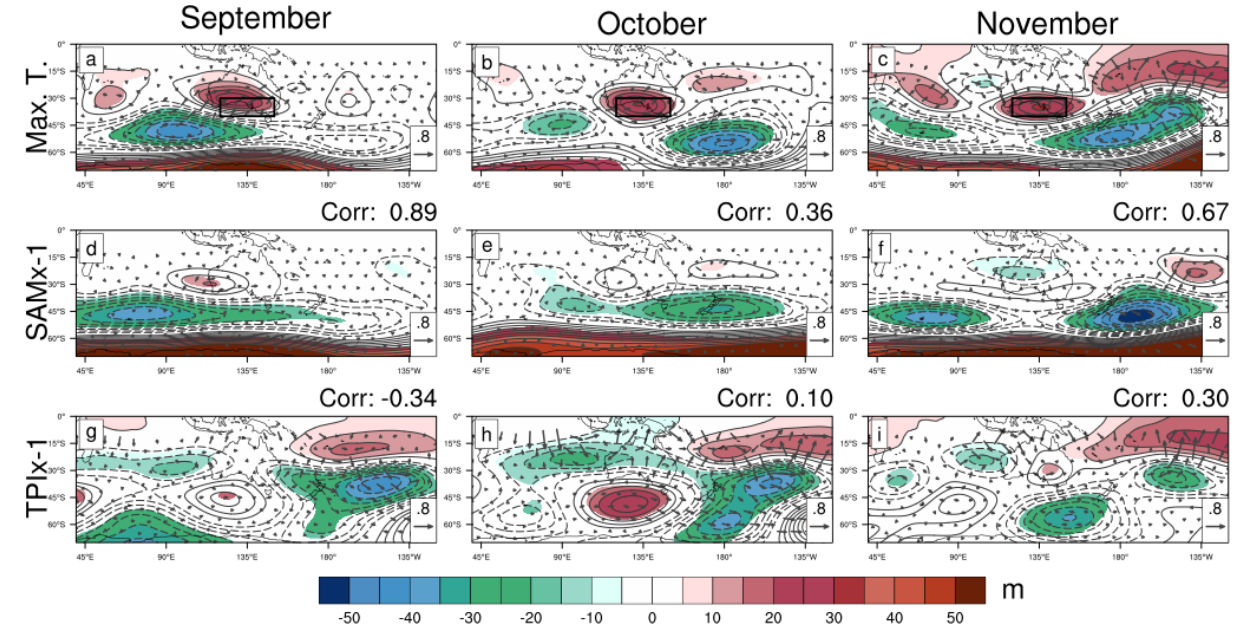
Figure 3. As with Fig. 2 but for upper-level circulation. The Australian-region pattern correlation between the maximum temperature Z200 regressions and SAMx-1 and TPIx-1 is in the top right of each figure. Boxed area (a–c) highlights the southern Australian anticyclone (SAA; 30–40 ◦ S, 120–150 ◦ E) that is linked with high maximum